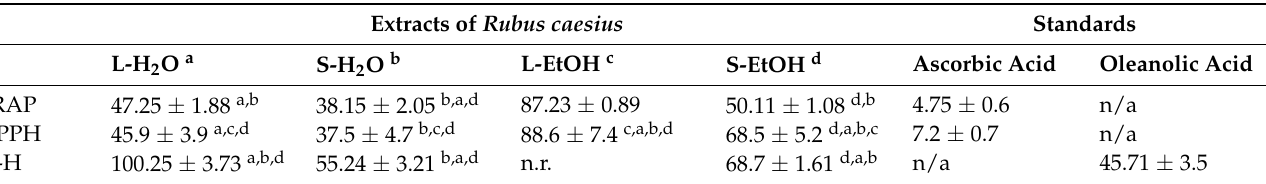
Table 1. Ferric reducing antioxidant power (FRAP, IC 50 ), radical scavenging potential (DPPH, IC 50 ) and hyaluronidase inhibitory activity (antihyaluronidase, IC 50 ) of the extracts from Rubus caesius [ µ g/mL of the dry